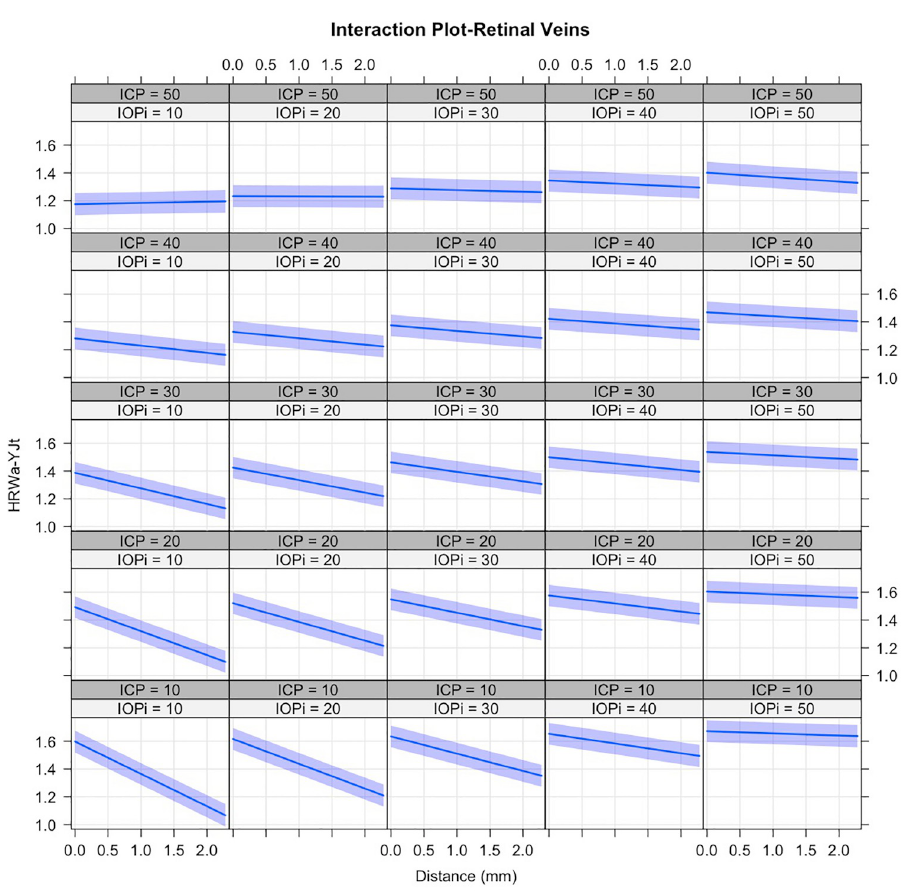
Fig 6. Trellis graph demonstrating the mixed effects linear regression model with interactions of the Yeo-Johnson transformed venous harmonic regression waveform amplitude (HRW a-YJt ). Distance is measured in millimeters (mm) from the center of the optic disc. The 95% confidence intervals are shown around the regression lines. Noted is a reduction of the slope of the regression with increased ICP (columns) and IOP i (rows). Whereas the y-intercepts of the regression lines are reduced with increased ICP, they are increased with higher IOP i . The progressively lower y- intercepts of the regression lines along the lower left to upper right diagonal indicate that a higher IOP i is required to induce a venous pulsation with higher ICP, which will be of a lower